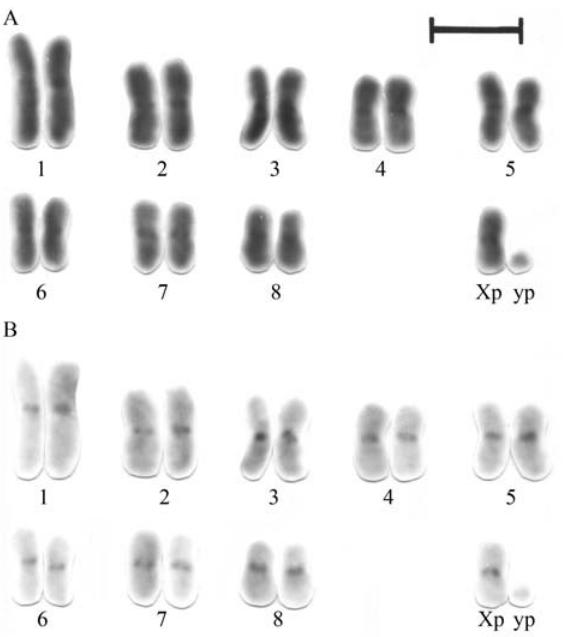
Figure 4 - Spermatogonial karyotypes of Astylus variegatus after Giemsa staining (A) and C-banding (B). The cells have 2n = 16+Xy p and constitu- tive heterochromatin in the pericentromeric region of all chromosomes, except for the y p . Scale bar = 5 μ m.